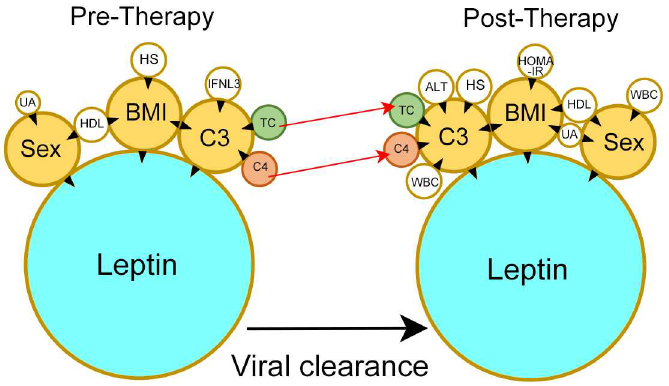
Fig 1. The leptin-centered associations between the dependent and independent factors before (pre- therapy) and 24 weeks after anti-hepatitis C therapy (post-therapy). Tips of black arrowheads: dependent factors; Bases of black arrowheads: independent factors; UA: uric acid; HDL-C: high-density lipoprotein-cholesterol; BMI: body mass index; HS: hepatic steatosis; IFNL3: interferon, λ 3; TC: total cholesterol; C3: complementcomponent 3; complementcomponent 4: C4; WBC: white blood cell; HOMA-IR: homeostasis model assessment-estimated insulinresistance; red arrows: post-therapeutic increasesin the TC and C4